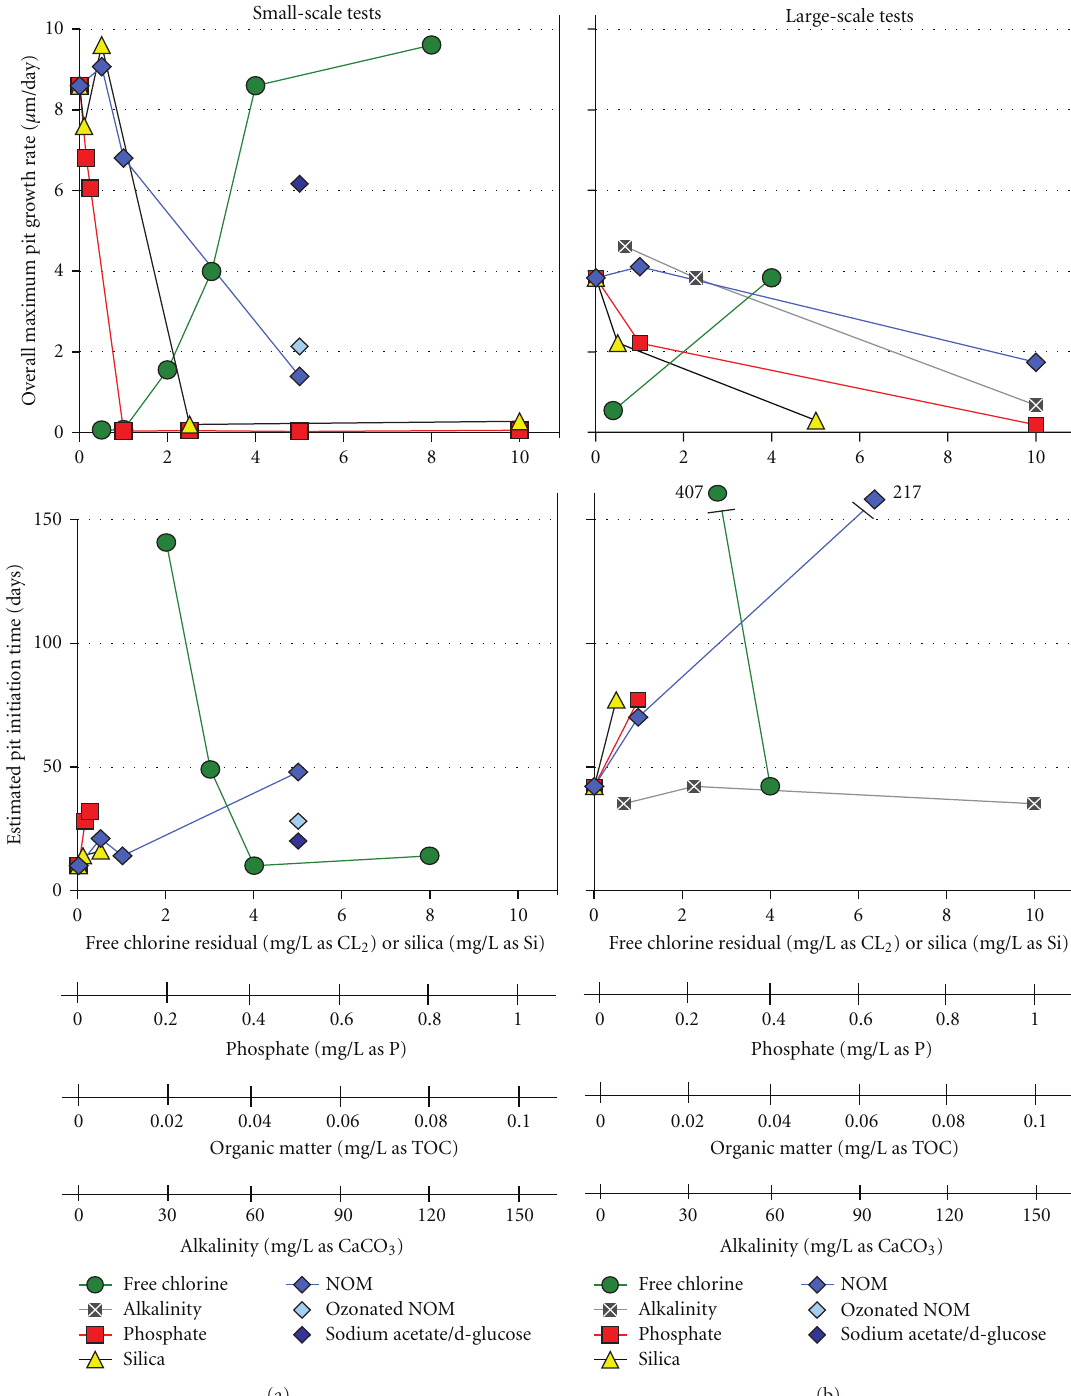
Figure 4: Overall maximum pit growth rate (top) and estimated pit initiation time (bottom) versus tested constituent concentrations for small- (a) and large-scale tests (b). Initiation times based on E pit = 325mV (versus Ag-AgCl); values not determined in tests where E pit not